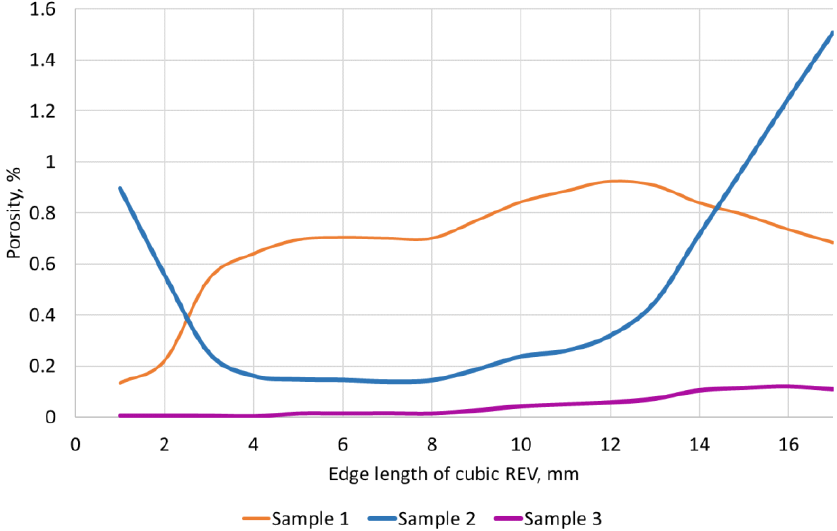
Figure 7. Porosity-based analysis of Representative Elementary Volumes (REV) of studied big sam- ples.